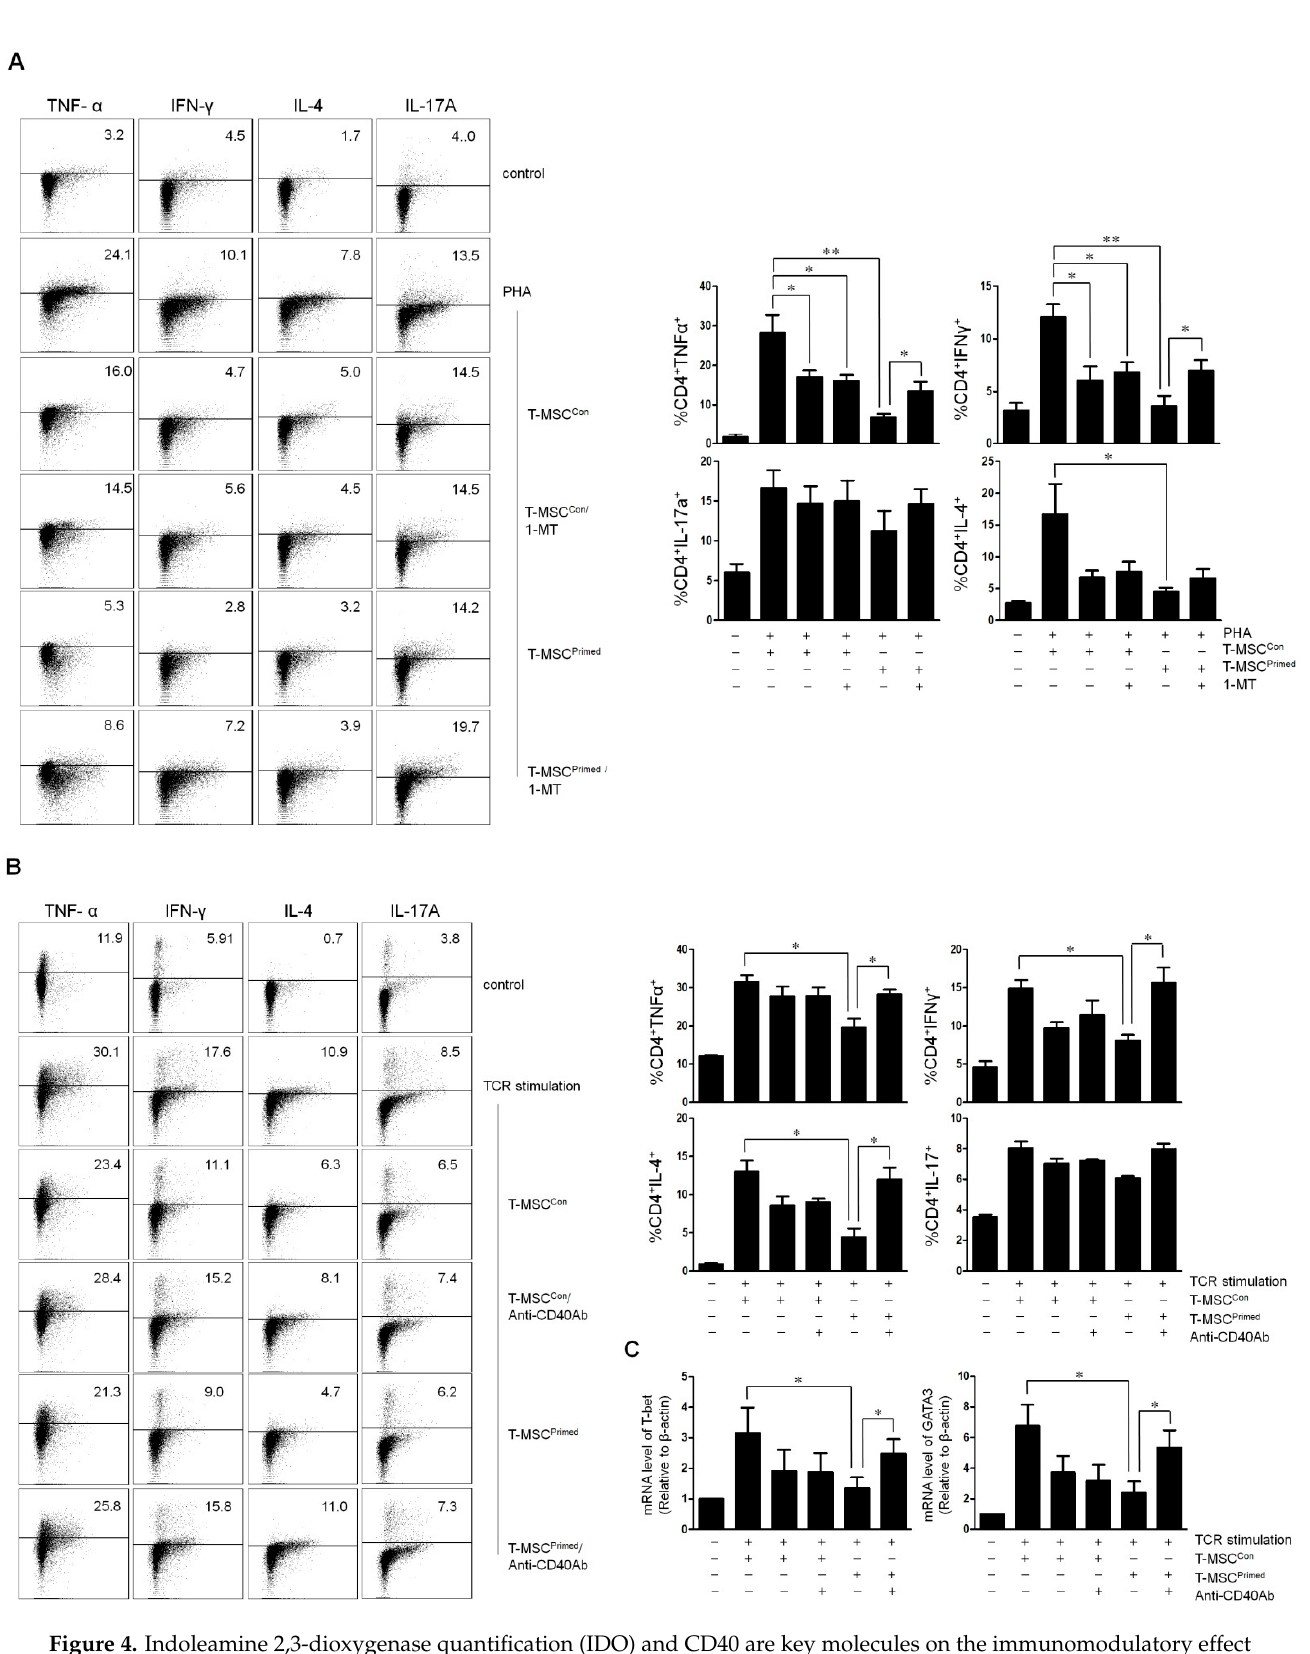
Figure 4. Indoleamine 2,3-dioxygenase quantification (IDO) and CD40 are key molecules on the immunomodulatory effect of the primed tonsil-derived mesenchymal stem cells (T-MSCs). ( A ) Expression of TNF- α , IFN- γ , and IL-4 in CD4 + T cells according to the different groups (control, PHA, T-MSC Con , T-MSC Primed and inhibitor IDO) ( B ) Expression of TNF- α , IFN- γ , and IL-4 in CD4 + T cells according to the different groups (control, TCR, T-MSC Con , T-MSC Primed , and Anti-CD40Ab) ( C ) Expression level of transcription factors of Th1 (T-bet) and Th2 (GATA3) both in the co-cultures of T-MSCs and CD4 + T cells according to the different groups (control, TCR, T-MSC Con , T-MSC Primed , and Anti-CD40Ab). Dot blots are representative of each independent experiment. The graphic data is the ± SEM from each independent experiment. * p < 0.05 and ** p < 0.01. T-MSC Con , tonsil-derived mesenchymal stem cell with the addition of vehicle control; T-MSC Primed , tonsil-derived mesenchymal stem cell primed with TNF- α and IFN- γ ; Anti-CD40Ab, Neutralizing anti-CD40 antibodies.